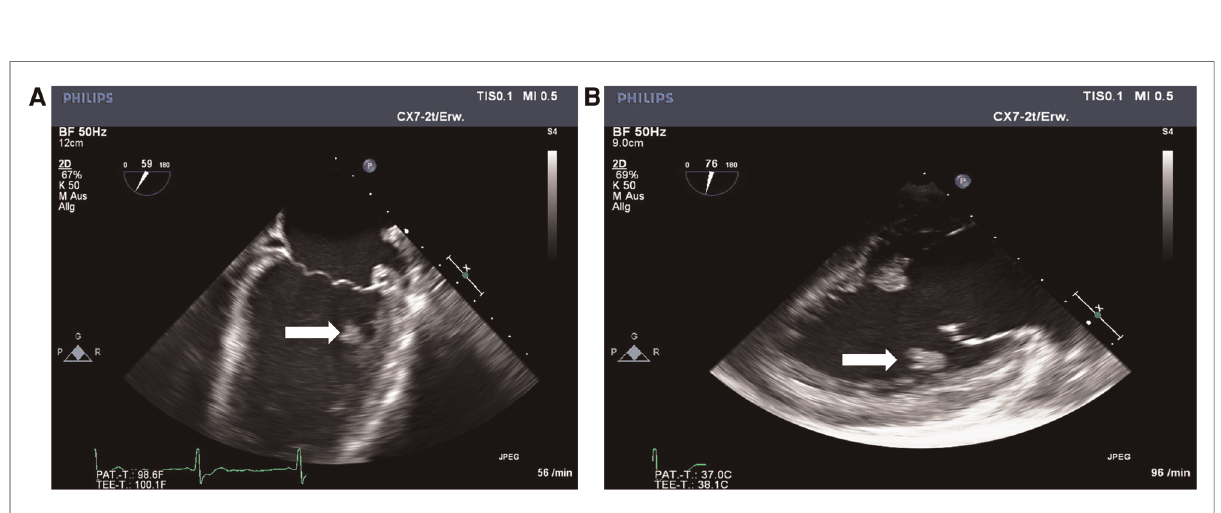
FIGURE 3 ( A and B ) Views on thrombus (white arrows) in the out fl ow tract of the left ventricle, day